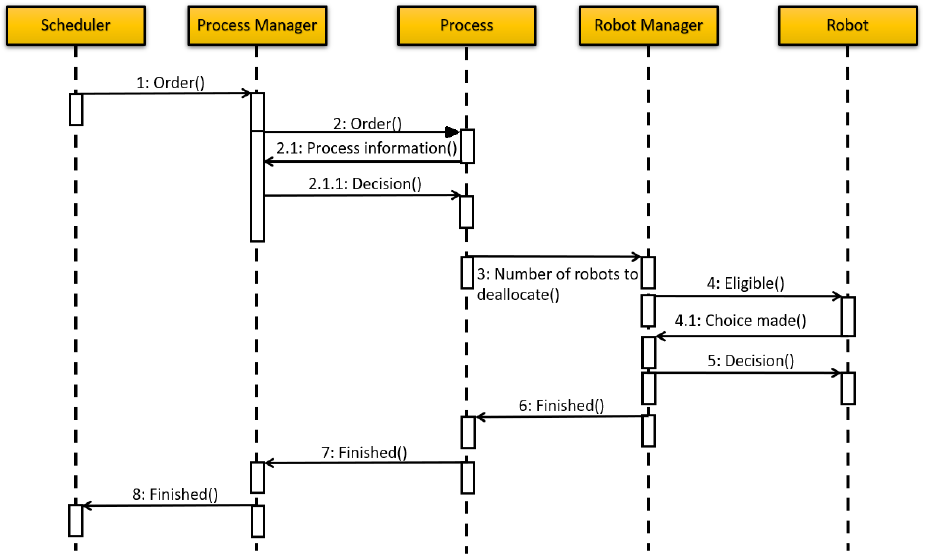
Figure 8. Sequence diagram of the CFRB